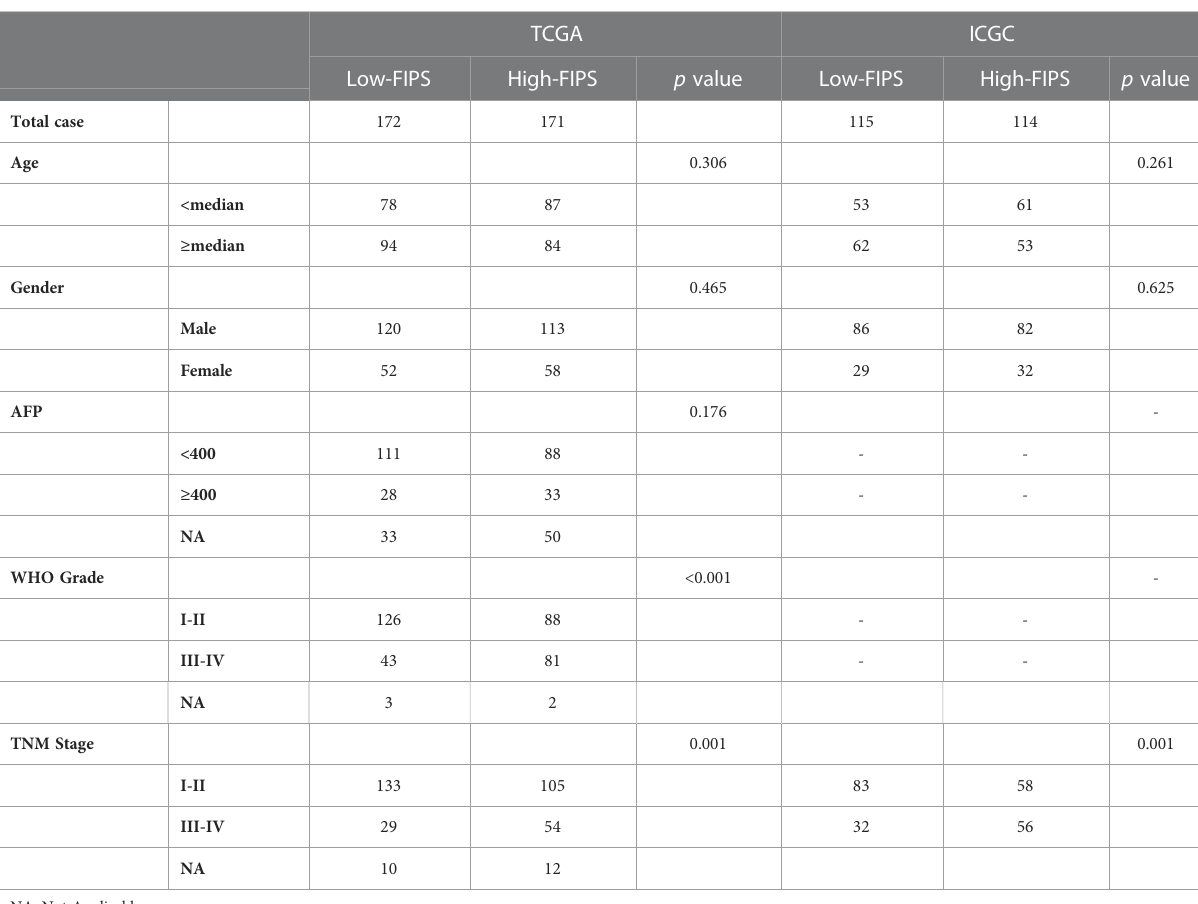
TABLE 2 Clinicopathological features in two